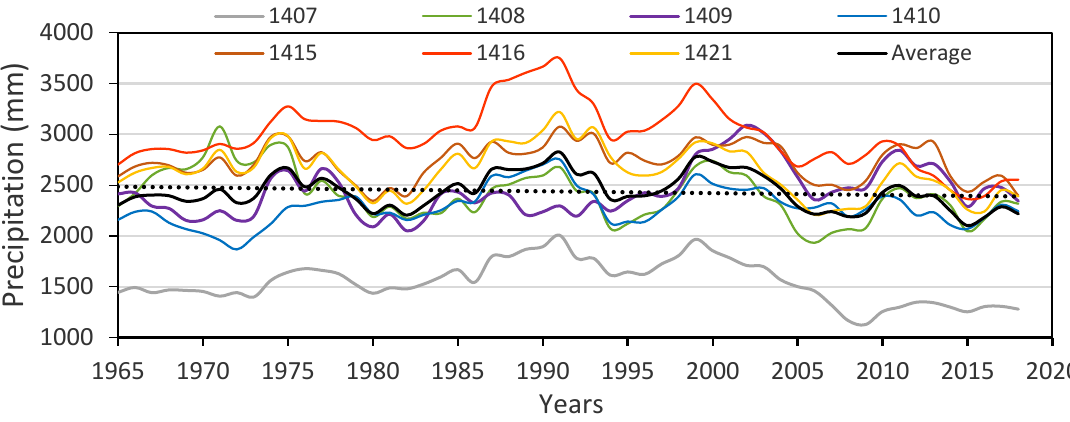
Figure 5. Five-year moving average annual precipitation at different stations and average for the KRB (the dotted line represents the trend line for the average precipitation of the basin).